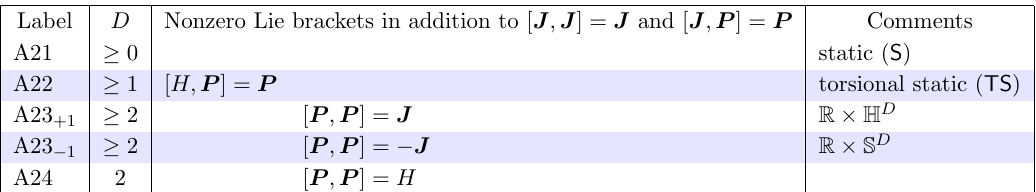
Table 2 . Simply-connected homogeneous ( D + 1)-dimensional aristotelian